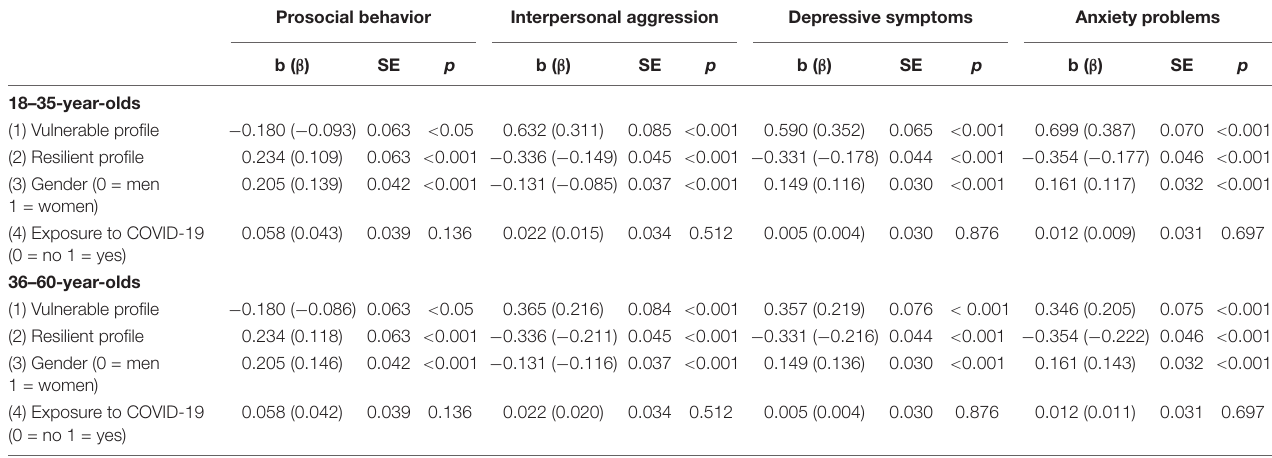
TABLE 3 | Profile Membership and covariates effects on Prosocial Behavior, Interpersonal Aggression, Depressive Symptoms, and Anxiety Problems during the first Italian Lockdown due to COVID-19 pandemic. Prosocial behavior Interpersonal aggression Depressive symptoms Anxiety